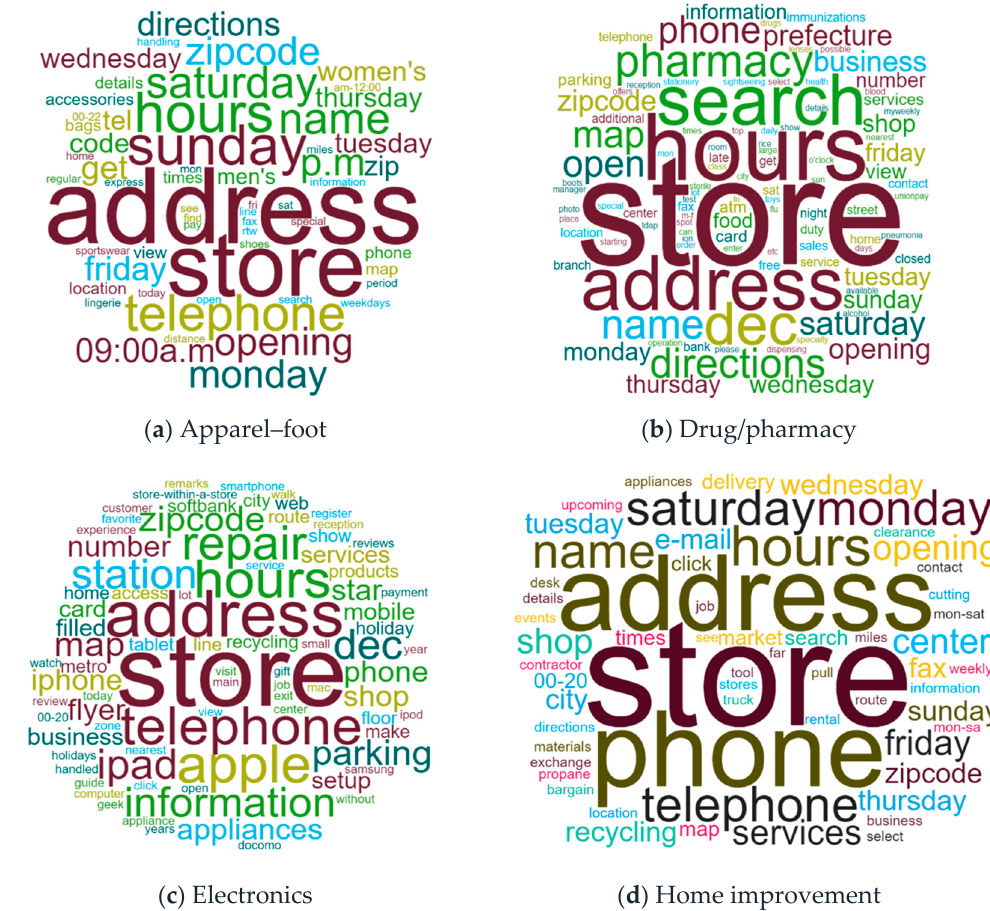
Figure 2. Word clouds on websites of specialty retailers (results retrieved from a search).